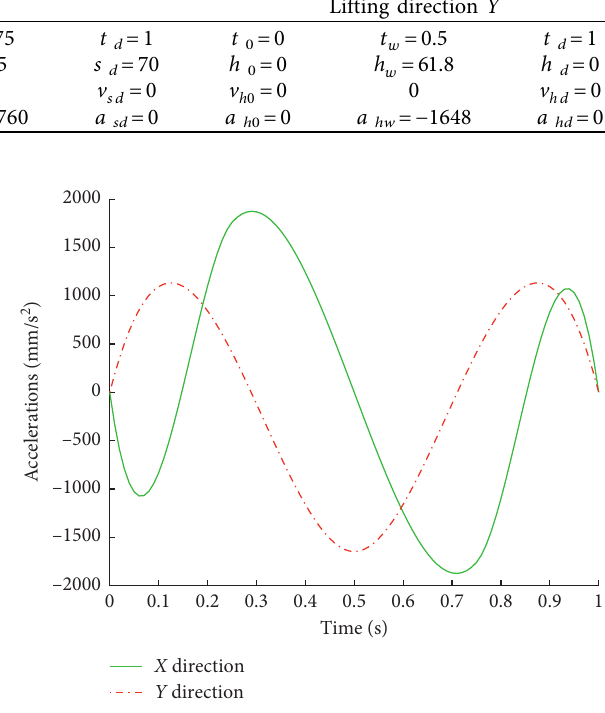
Figure 5: Acceleration curve of submovement of